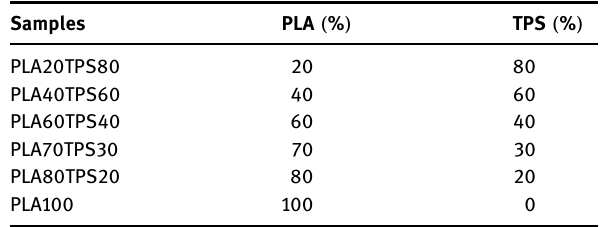
Table 2: The composition of PLA/TPS blend